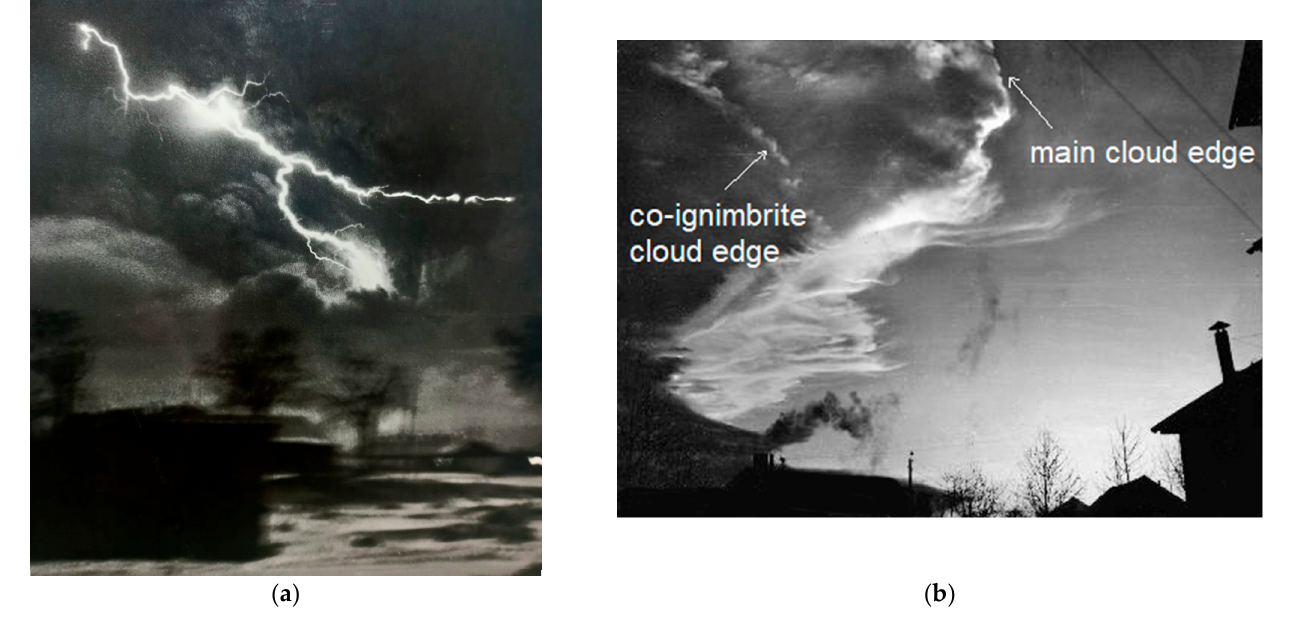
Figure 2. Visual data for the Sheveluch eruption on 11 November 1964: ( a ) Lightning bolts in the eruptive cloud above Sheveluch. Photo by L. Dorofeev from Klyuchi; ( b ) Double-layer eruptive cloud above Ust-Kamchatsk. Photographer unknown (http://www.kscnet.ru/ivs/history/dates/images/Shvl64_1.jpg (accessed on 1 July 2022)).